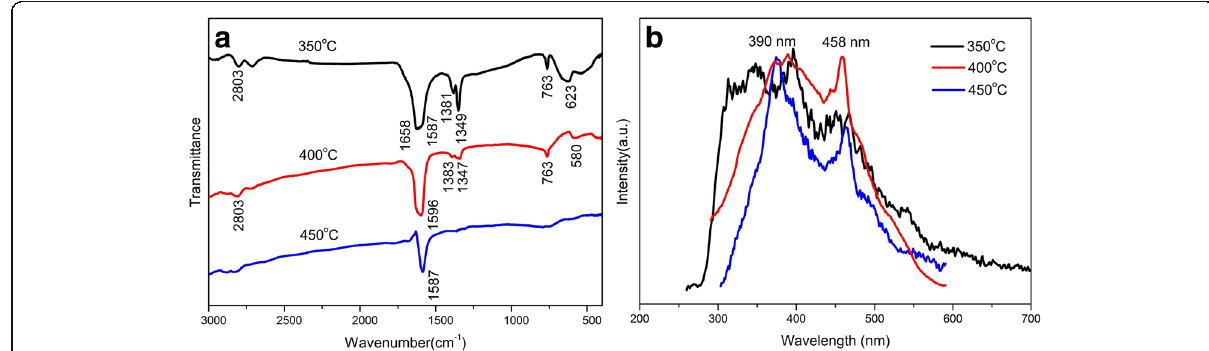
Fig. 5 a FTIR spectra. b The photoluminescence spectra of mesoporous SnO 2 samples (the excitation wavelength is 310